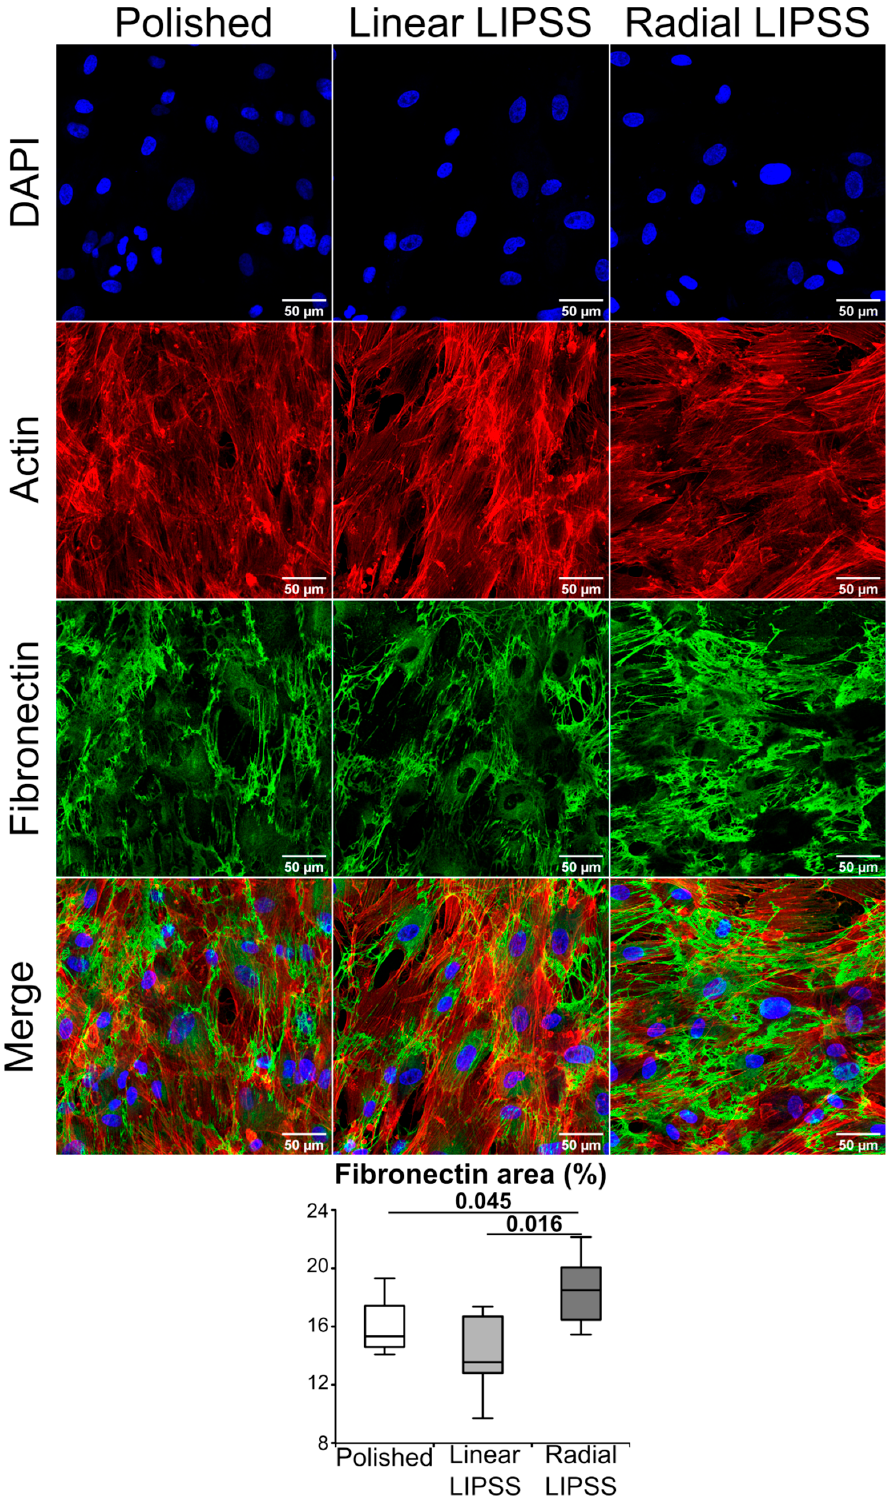
Figure 3. DAPI nuclear staining (blue), rhodamine-conjugated phalloidin labeled actin (red), fibronectin antibody coupled with a 488 fluoroprobe (green) and overlaid fluorescent image of immunostained cellular component (merged) for the cells cultured on polished linear LIPSS and radial LIPSS surfaces 7 d post seeding. On the bottom of the image is the result of the fibronectin area for the three surfaces. The graph gives the p -values between each group, Mann–Whitney U test, n = 8